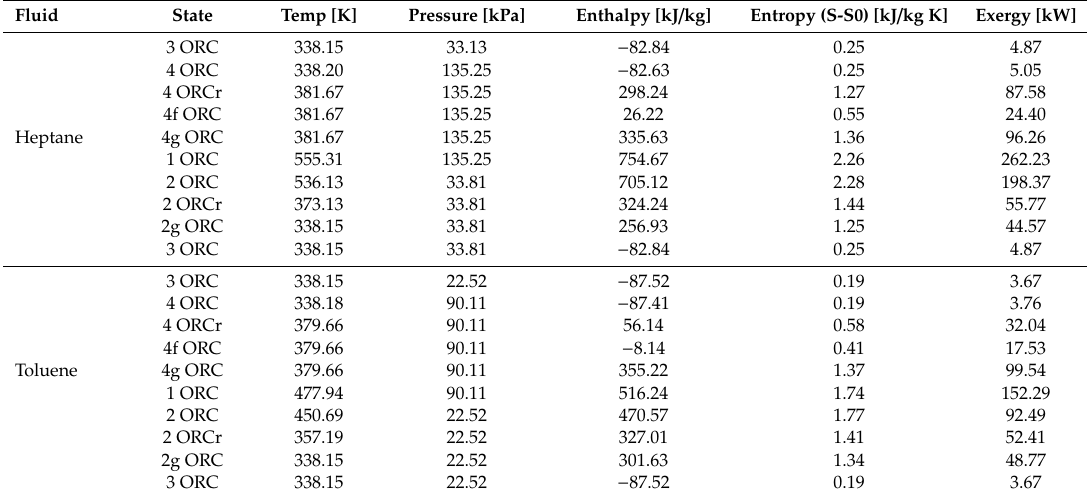
Table A1. Thermodynamic properties of the WHRS system based on RORC system for heptane and toluene as working